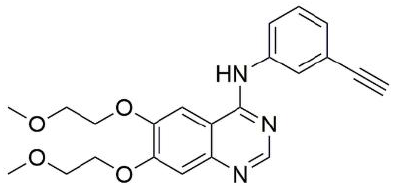
Figure 10. Structure of reference drug erlotinib.